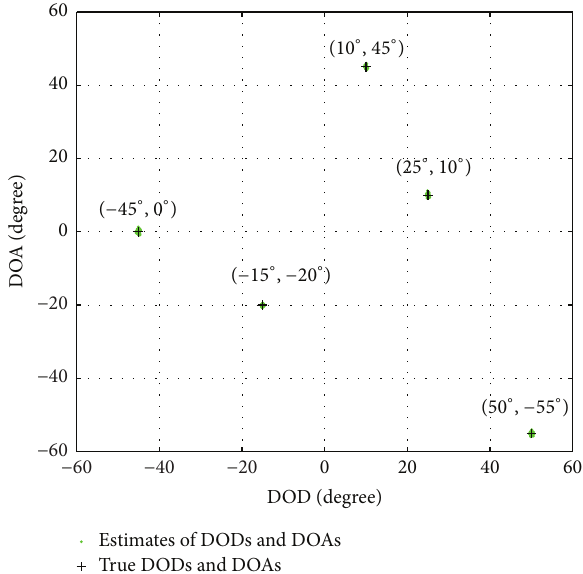
Figure 1: Paired results of the proposed algorithm for all five targets.